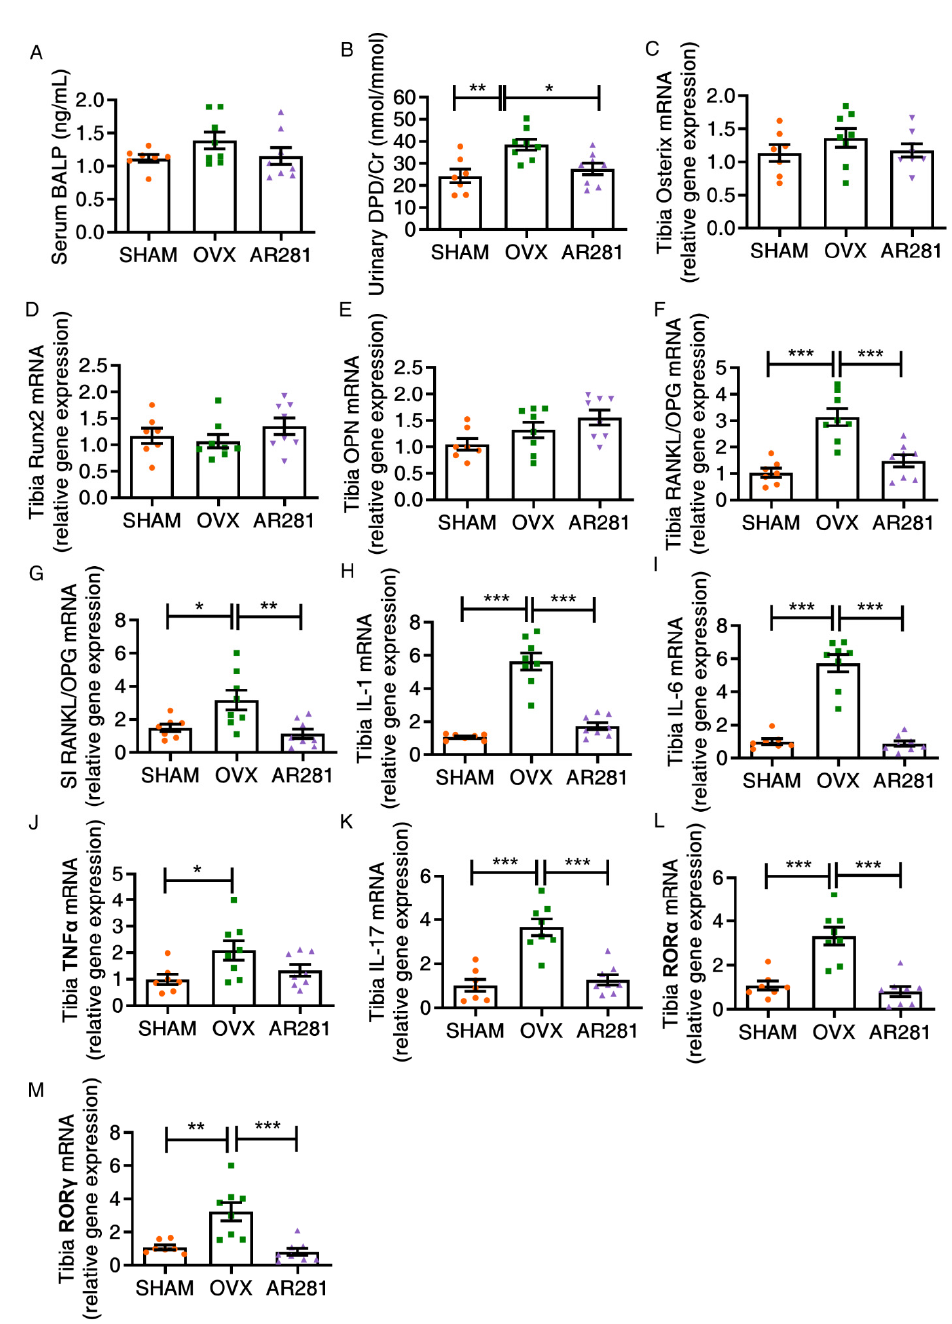
Figure 5. The effects of L. brevis AR281 on osteoclastogenic signaling in the tibia: ( A ) bone alkaline phosphatase (BALP) in serum; ( B ) the ratio of urinary deoxypyridinoline (DPD) to creatinine; ( C –